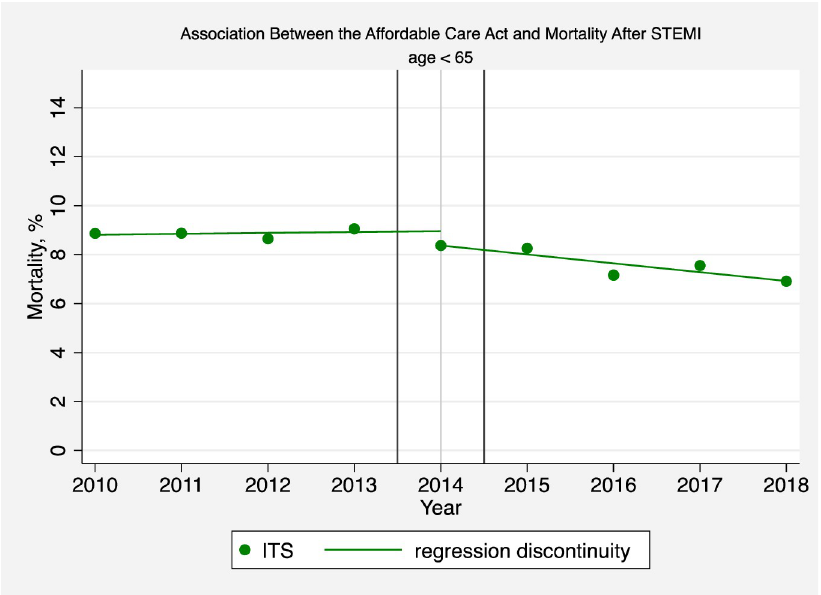
Fig 4. Association between the affordable care act and mortality after STEMI (age < 65). The solid circles represent the yearly estimates for the mortality rate in patients hospitalized with a STEMI based on an interrupted time series (ITS) model after adjusting patient-level and hospital effects, without imposing restrictions on time trends and making no assumptions that time effects were different before or after 2014. The solid line is based instead on a regression discontinuity model, and assumes that pre-intervention and post-intervention trends are linear in order to interpret changes in mortality rates before and after the ACA.